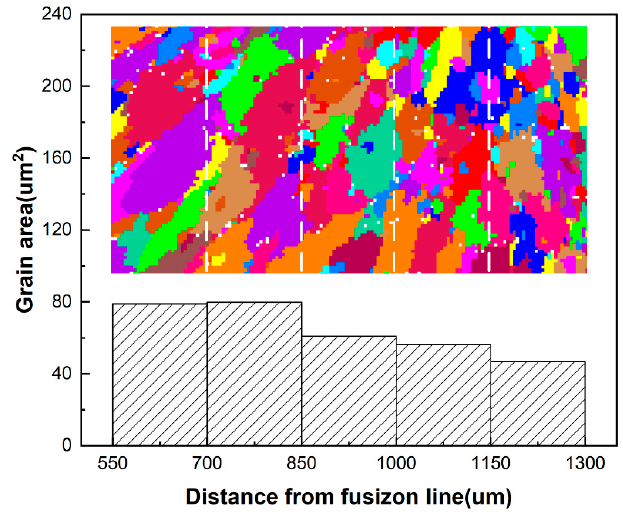
Figure 22. The size distribution of equiaxed grain in the fusion zone.